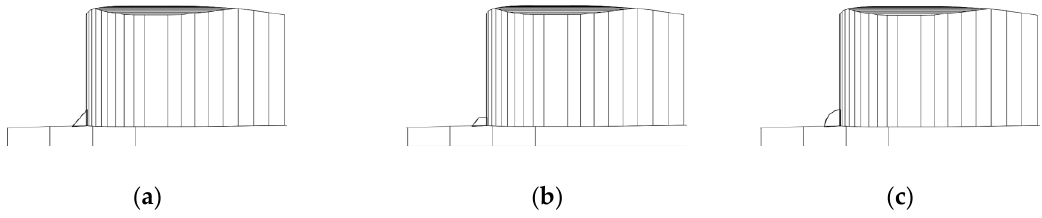
Figure 7. The mechanical vortex generators (VGs) on the model: ( a ) triangular; ( b ) trapezoidal; ( c ) semi-circular.